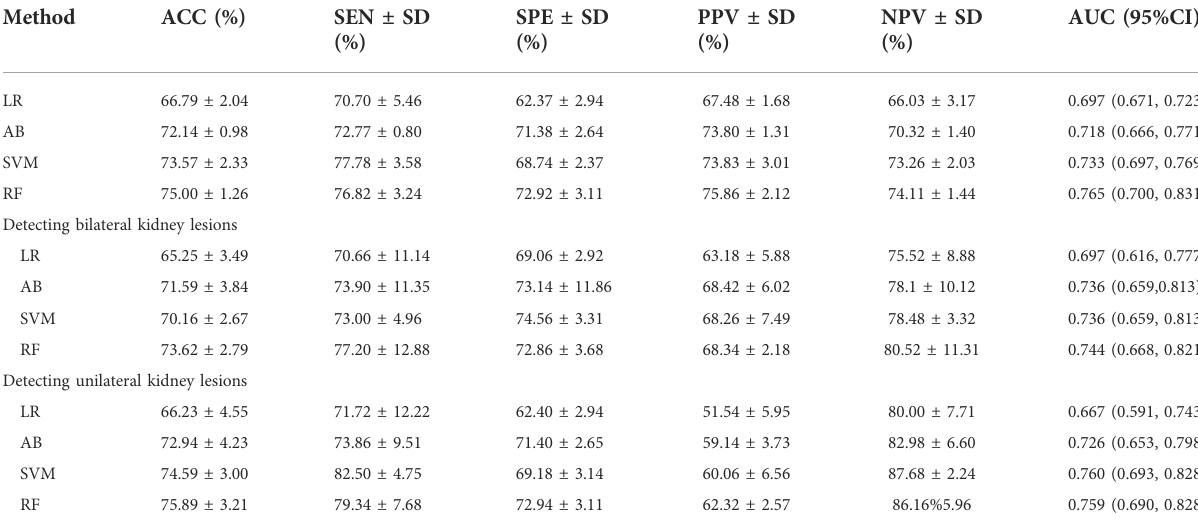
TABLE 2 Parameters of detecting kidney lesions by radiomics analysis of DWI